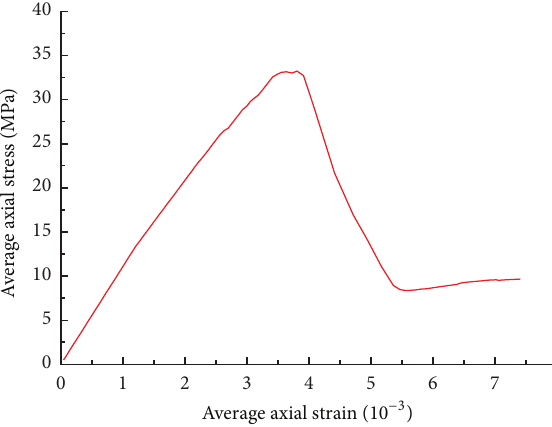
Figure 10: Average axial stress-strain curve for a pillar with width-to-height ratio = 1.0.